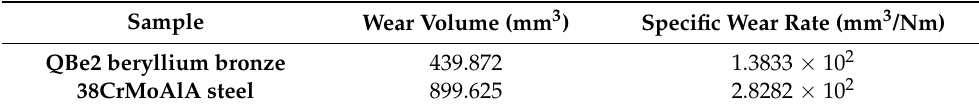
Table 2. Wear volume and specific wear rate of the proposed tribo-pair without lubrication for about 50 h